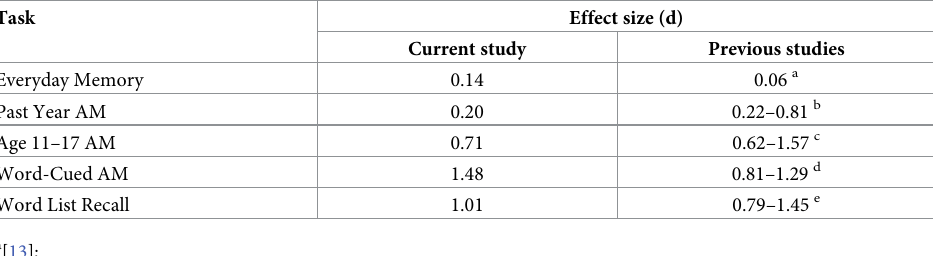
Table 6. Comparison of effect sizes for age effects in current study and previous studies employing similar